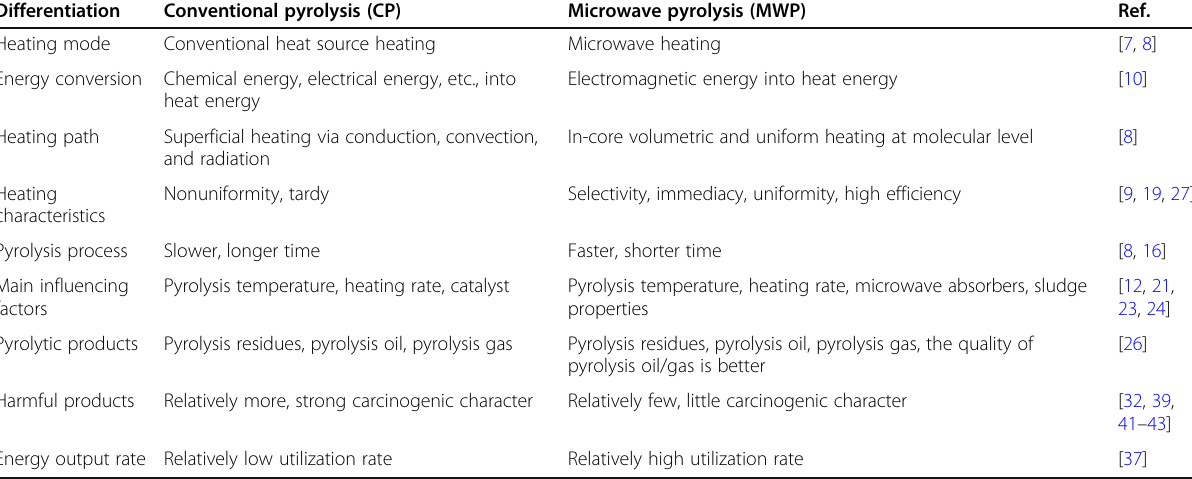
Table 3 The differentiation between conventional pyrolysis and microwave pyrolysis Differentiation